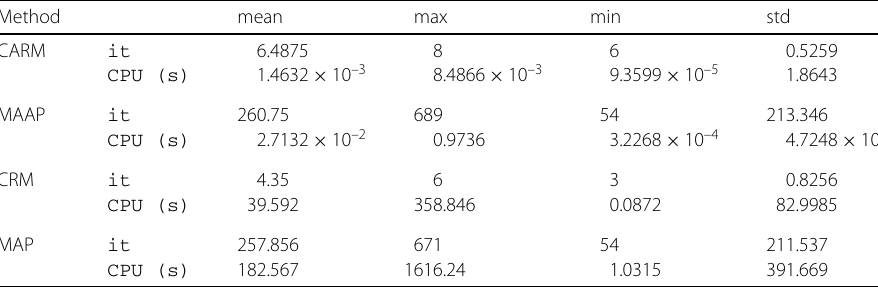
Table 1 Statistics of the experiments (in number of iterations and CPU time) Method